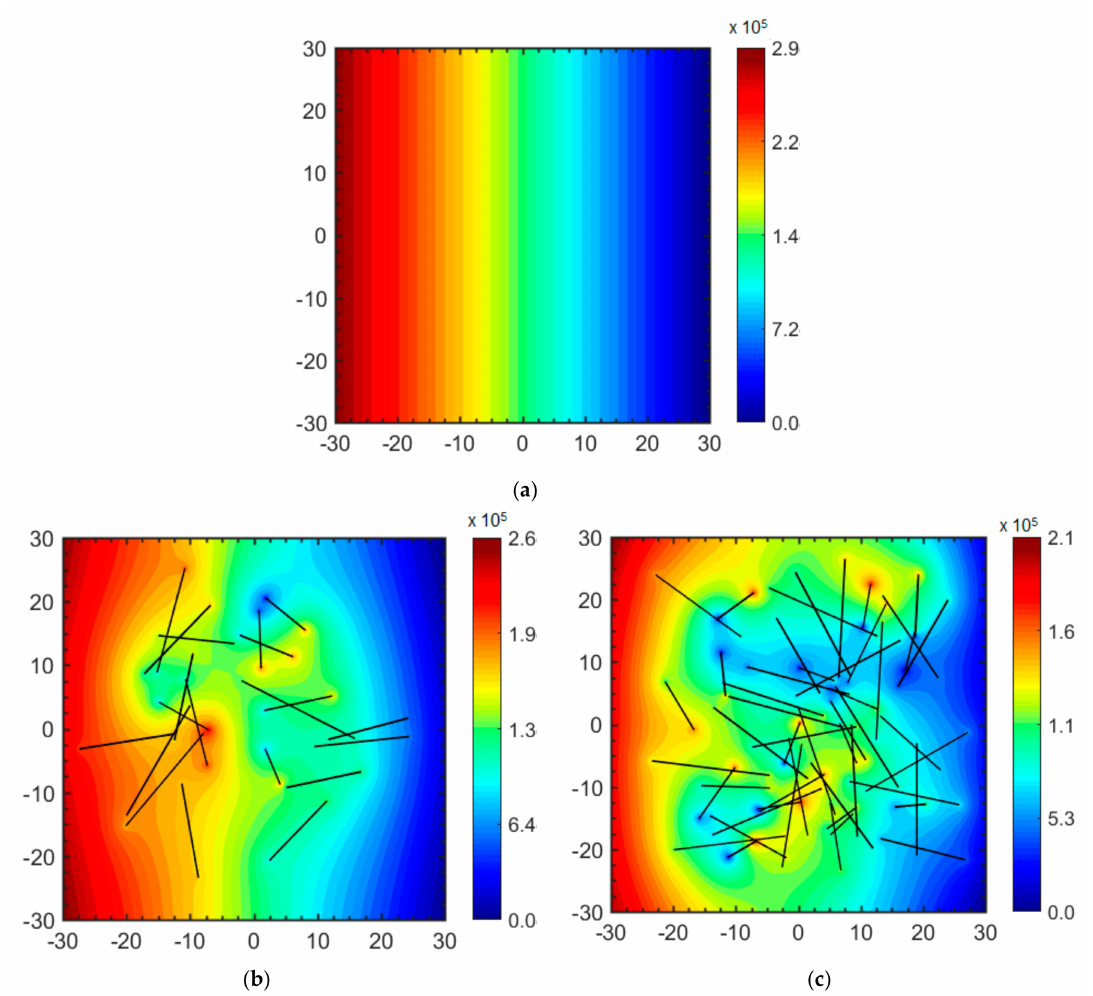
Figure 18. Pressure field (in Pascal) for: ( a ) Base case: Far-field flow for an isotropic reservoir. ( b ) Case C: 20 randomly generated enhanced permeability flow channels. ( c ) Case D: 50 randomly